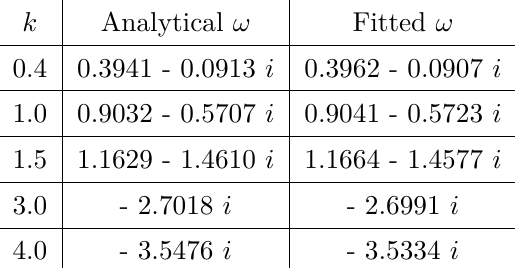
Figure 16 . Quasinormal sound ringdown profiles for q 0 /ρ 0 = 0 . 7 at several values of the wavenum- ber k . The phenomenon of charged silence can be clearly seen, as the modes with k > 1 /a do not propagate and simply decay exponentially.